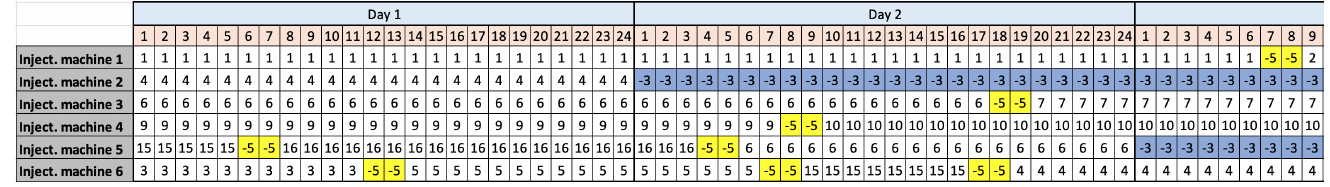
Figure 2. Illustration of a part of a